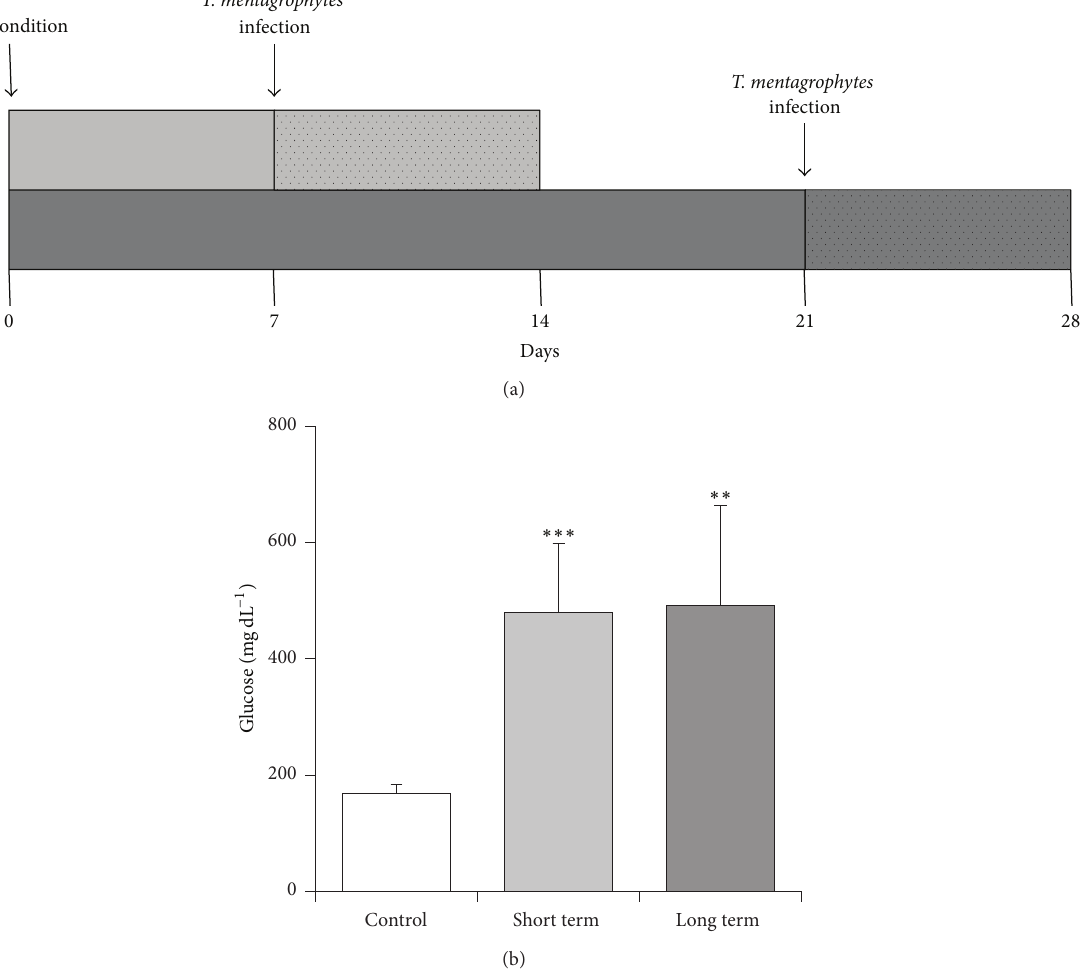
Figure 1: Experimental design. Mice were intravenously inoculated with alloxan (60mgkg −1 ) into the caudal vein. Hyperglycemia was confirmed after 48 h by blood glucose levels > 200mg dL −1 . (a) Mice that were exposed to HH condition for 7 days constituted the HH group (short term) and those for 21 days constituted the HH group (long term). Mice from HH groups (short and long term) were infected with 2 × 10 7 T. mentagrophytes microconidia into footpad. (b) Glucose levels (mgdL −1 ) after 7 days (short term) and 21 days (long term) of HH installation. The results are expressed as mean ± SD ( 𝑛 = 6 – 12 /group). Unpaired 𝑡 -test, 𝑝 < 0.05 . ∗ 𝑝 < 0.05 and ∗∗ 𝑝 < 0.01 indicate statistical differences among HH group versus the control group (uninfected/HH-free